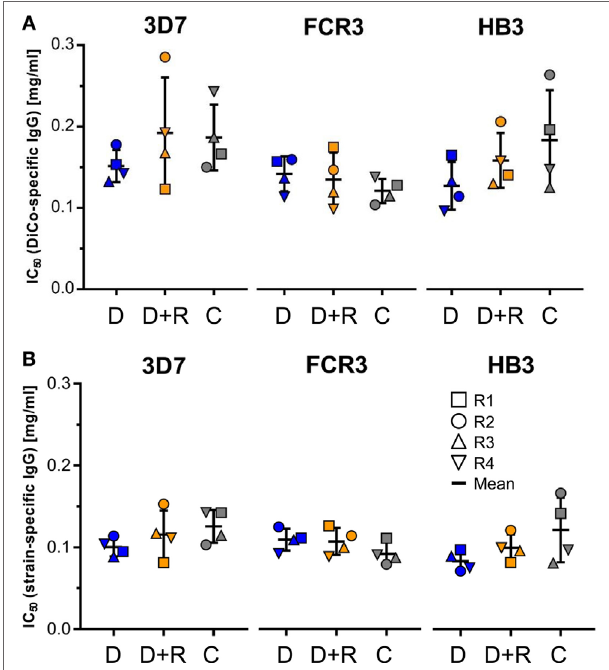
FigUre 5 | Growth inhibition assay. The parasite growth-inhibitory activity of the immune IgG preparations from the three different rabbit groups (see below) were assessed using three P. falciparum strains (3D7A, FCR3, and HB3). A serial dilution of purified IgG preparations starting at 6 mg/ml total IgG were used to determine IC 50 values for the three P. falciparum strains. Based on the antigen-specific antibody concentrations ( Table 1 ), IC 50 values are expressed in micrograms per milliliter DiCo-specific IgG (a) and micrograms per milliliter allele-specific IgG (B) . D: group of rabbits that were vaccinated using 50 µg DiCo-Mix; D + R: group of rabbits that were vaccinated using 50 µg DiCo-Mix and 50 µg of Pf Ron2L peptide at different injection sites; C: group of rabbits that were immunized with the DiCo– Pf Ron2L complex formed by mixing 50 µg of DiCo-Mix and 50 µg of Pf Ron2L. To facilitate the complex formation, the DiCo– Pf Ron2L mixture was incubated for 30 min at room temperature before formulation with the adjuvant and